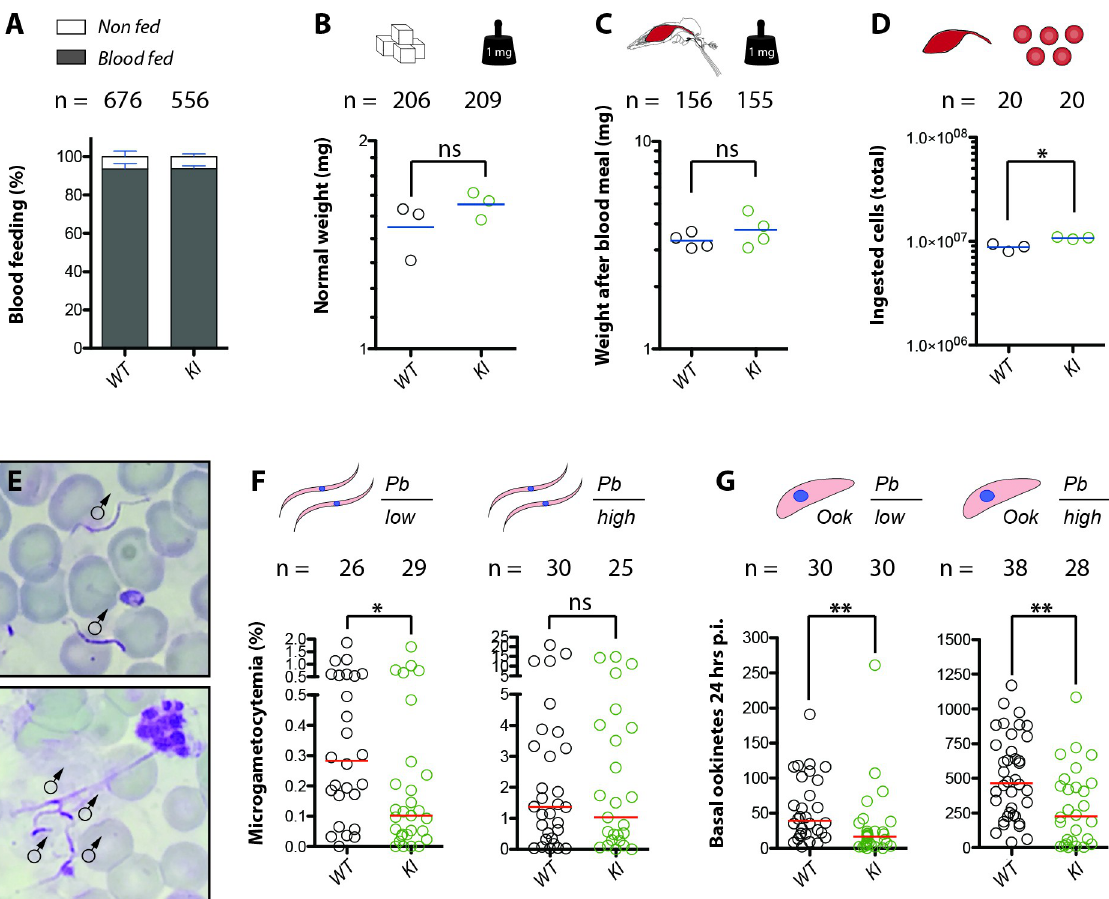
Fig 3. Absence of Saglin impairs exflagellation and reduces the number of ookinetes successfully traversing the midgut. A) Percentage of blood fed wild-type (WT) and sag(-)KI (KI) females after 10 minutes of feeding. Mean and standard error of the mean (SEM) of four independent experiments. B) Mean weight of females kept with sugar feeding (3 independent experiments). C) Weight of single females after blood feeding and D ) red blood cell count (#RBC) in the blood meal after 10 minutes of blood feeding of wild-type ( Ngousso) and sag(-)KI females. Data represent pooled results from four (blood feeding, #RBC) and three (sugar feeding) experiments, respectively. Blue lines indicate the mean. Experiments were performed � 4 days after eclosion. Paired t test: ns = 0.1117 (weight sugar); ns = 0.3273 (weight blood); � p = 0.0158 (#RBC). Note that for all (A,B,C,D) but two of the four experiments of (C), larvae of sag(-)KI and wild type were reared as a mixture to avoid growth differences caused by unequal feeding. E) Diff-Quik stained smears of mosquito blood meals 10–12 minutes after feeding. Exflagellated male gametes are visible as elongated spirochete-like cells. Due to the recording method, it was not possible to draw a precise scale; red blood cells have an approximate diameter of 7 μ m. F) Percentage of exflagellated male microgametes in the blood meal in relation to the total number of red blood cells (microgametocytemia) 10–12 minutes after feeding, and number of ookinetes ( G ) visible on the basal side of the midgut epithelium of wild-type ( Ngousso) and sag(-)KI mosquitoes at 24 hpi (two independent experiments each). Mosquitoes were infected using mice with low ( Pb low ) or high ( Pb high ) parasitemia. Red lines indicate medians, with comparisons using the Mann Whitney test: �� p < 0.01; � p < 0.05; ns p > 0.05. Note that the data in F and G have not been corrected for small differences in the ingested blood volume between wild-type and sag(-)KI